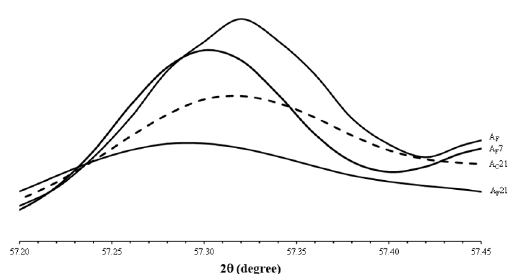
and composites F